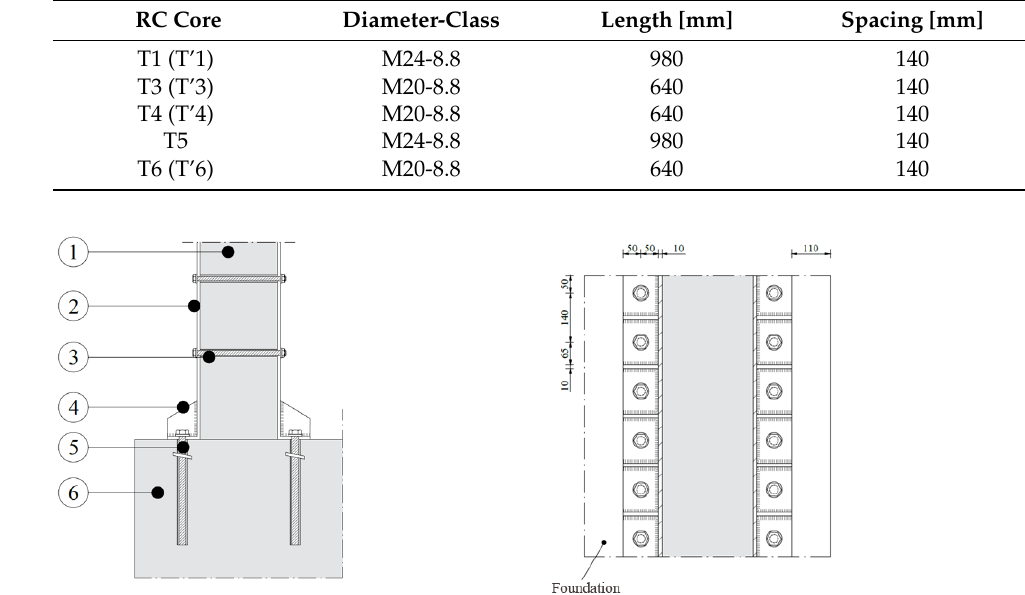
Table 15. Main properties of anchor bolts.